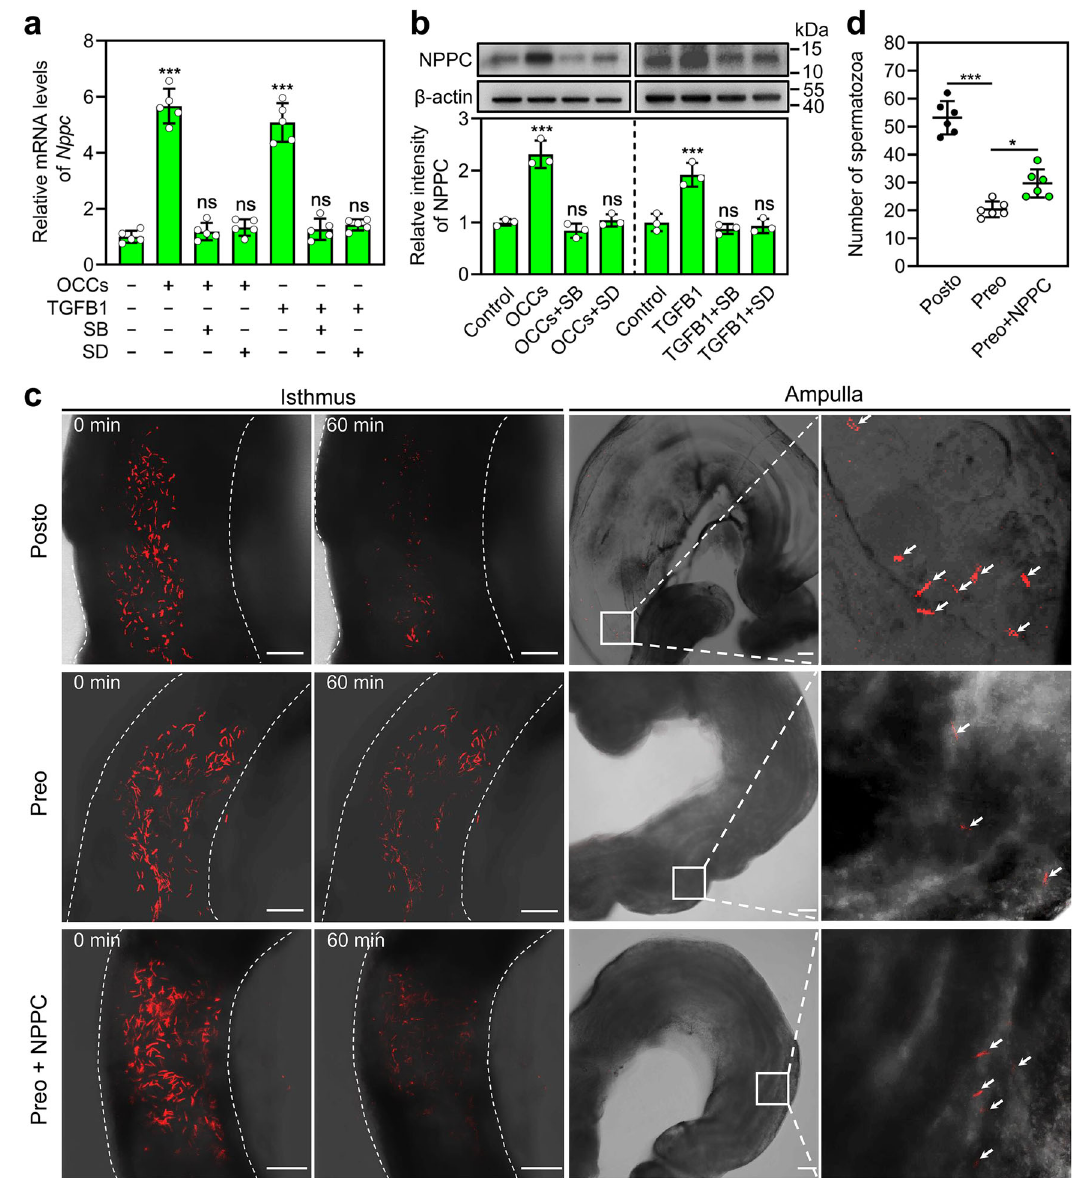
Fig. 3 OCC-stimulated NPPC promotes sperm migration from the isthmic reservoir to the ampulla. a , b OCC and TGFB1-induced NPPC mRNA ( a ) and protein ( b ) levels were blocked by SB431542 and SD208. ( n = 5 independent experiments in ( a ) and n = 3 independent experiments in ( b ). The ampullae were isolated from superovulated mice at 11 h post-hCG (without OCCs in the ampullae), and OCCs were collected from the ampullae of superovulated mice at 13 h post-hCG treatment. The ampullae were cultured with OCCs (3 OCCs/ μ l), TGFB1 (5 ng/ml), SB431542 (SB, 5 μ M), and/or SD208 (SD, 1 μ M) in a 50 μ l drop for 3 h, and NPPC mRNA and protein levels were determined at the end of the culture. β -actin was used as a loading control. Each data point represents a biologically independent experiment. c Representative frames from the time-lapse imaging of the oviductal lower isthmus (left panel) and representative images of the ampulla at the end of the time-lapse imaging (right panel). ( n = 6 mice in each group). The dashed line represents the edge of the lower isthmus. Oviducts were isolated from mice at the stated time. Ampli fi ed views of the boxed area are shown on the right-hand side. Arrow indicates spermatozoon in the oviductal ampullae. Scale bars represent 100 μ m. Posto, postovulatory oviduct; Preo, preovulatory oviduct. d The number of spermatozoa in the ampullae at the end of the time-lapse imaging ( n = 6 mice in each group). Each data point represents a single mouse. Statistical analysis was performed by one-way ANOVA Tukey test. Bars indicate the mean ± SD. ns, no signi fi cance ( P ≥ 0.05). * P < 0.05 and *** P < Conditional deletion of Tgfb1 and Tgfbr2 blocks NPPC analysis revealed that TGFB1 and TGFBR2 were speci fi cally expression and sperm migration in the oviduct . To study reduced in cumulus cells and ampullary epithelial cells, respec- tively (Fig. 4a). The knockout ef fi ciency was also con fi rmed by whether cumulus cell-derived TGFB1 promoted NPPC expres- Western blotting (Fig. 4b). Histological and co-staining analyses sion in the ampulla, we produced conditional knockout (cKO) indicated that Tgfbr2 deletion in epithelial cells had no obvious mice with inactivated TGFB1 in the cumulus cells ( Tgfb1 cKO ) by crossing Tgfb1 fl / fl mice with Fshr – Cre mice, and cKO mice with effect on the microstructure of the oviducts or distribution or the inactivated TGFBR2 in epithelial cells ( Tgfbr2 cKO ) by crossing relative number of ciliated and secretory cells in the oviductal Tgfbr2 fl / fl mice with Wnt7a – Cre mice. Immuno fl uorescence epithelium (Supplementary Fig. 6). We also stained sections of